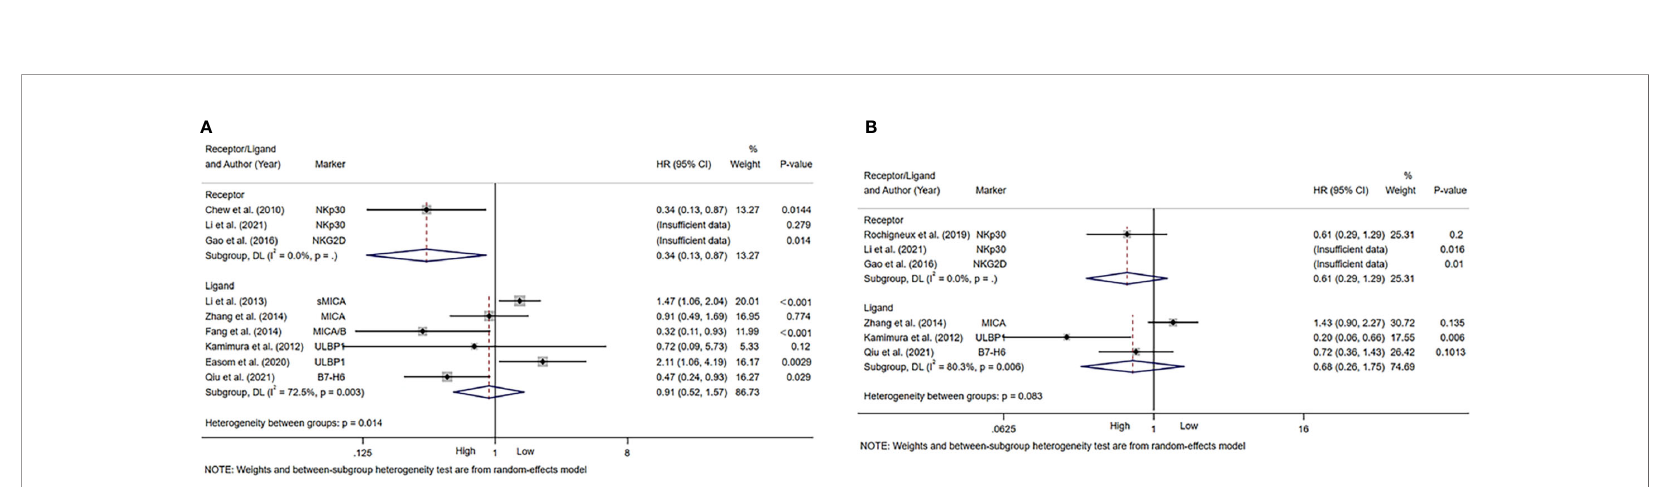
FIGURE 4 | Forest plot of NK cells activating receptors/ligands in HCC. (A) Forest plot of NK cells activating receptors/ligands and OS in HCC. (B) Forest plot of NK cells activating receptors/ligands and DFS/RFS/PFS in HCC. CI, Con fi dence interval; HR, Hazard ratio; HCC, Hepatocellular carcinoma; NK, Natural killer; OS, Overall survival; DFS, Disease-free survival; RFS, Recurrence-free survival; PFS, Progression-free